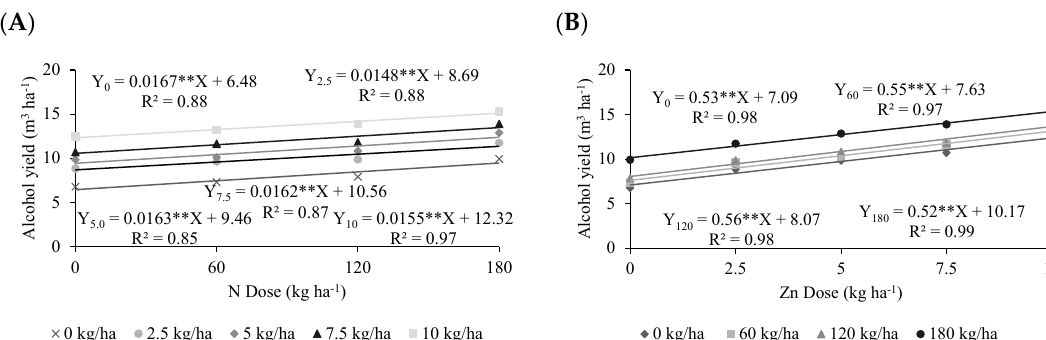
Figure 7. Alcohol yield of sugarcane (ratoon crops) in response to nitrogen ( A ) and zinc ( B ) fertigation doses, under field conditions in Jataí, GO, Brazil. ** significant at p < 0,01 probability according to the F test. Doses of Zn, Y 0 : 0 kg ha − 1 of Zn, Y 2.5 : 2.5 kg ha − 1 of Zn, Y 5.0 : 5.0 kg ha − 1 of Zn, Y 7.5 : 7.5 kg ha − 1 of Zn and Y 10 : 10 kg ha − 1 of Zn ( A ). Doses of N, Y 0 : 0 kg ha − 1 of N, Y 60 : 60 kg ha − 1 of N, Y 120 : 120 kg ha − 1 of N, Y 180 : 180 kg ha − 1 of N ( B ).